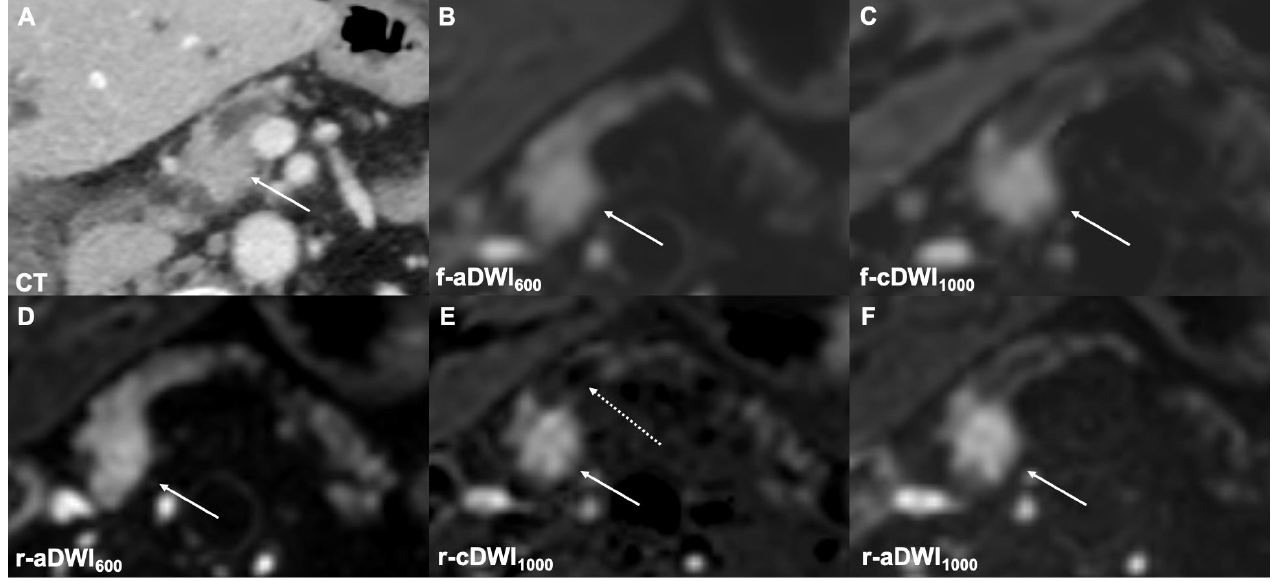
Figure 4. A CT image of a tumor in the pancreatic head causing obstruction of the main pancreatic duct ( A ). No clear tumor detection (type 3) is visible in the acquired images at b = 600 s/mm 2 ( B , D ). The tumor conspicuity is superior in the images at b = 1000 s/mm 2 ( C , E , F ). The fluid signal in the main pancreatic duct is best-suppressed in the r-cDWI1000 images ( E , dotted arrow). The labeling in image ( E ) has been corrected.